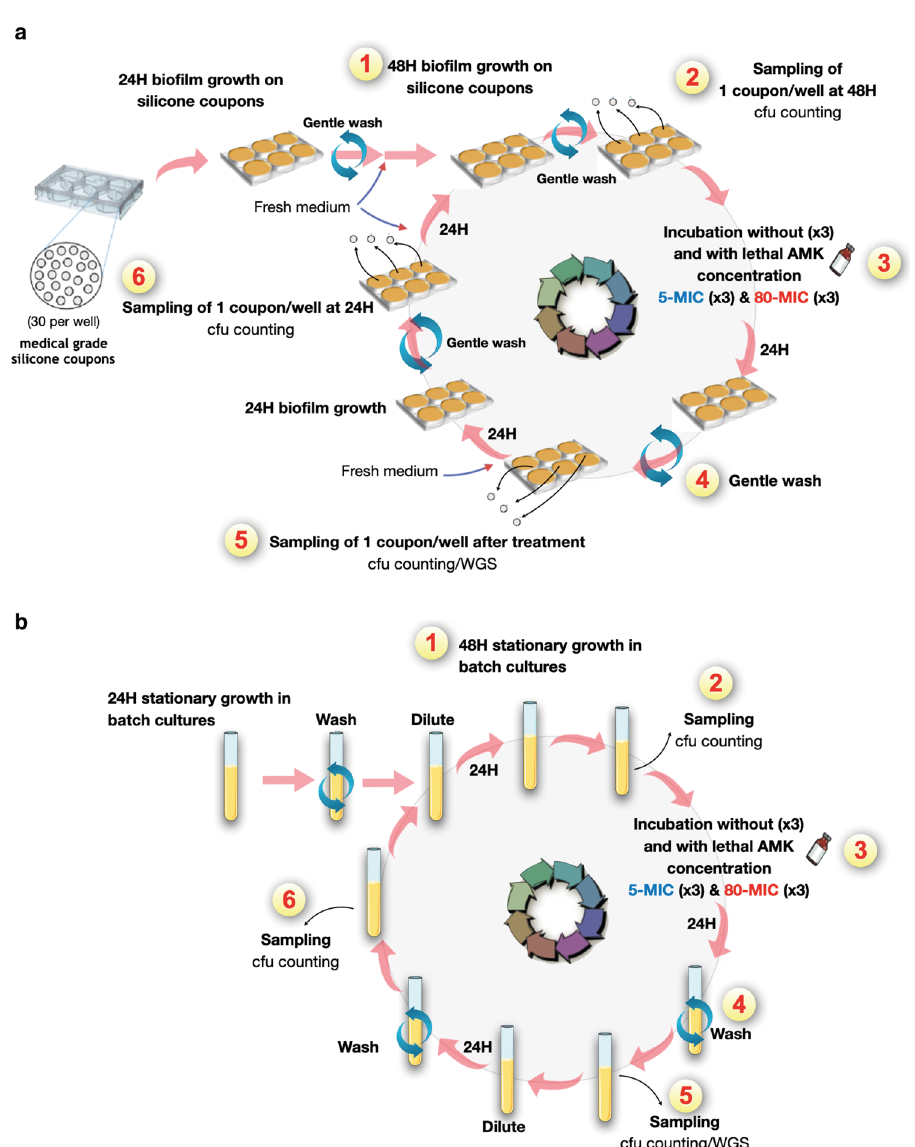
Fig. 1 Schematics of experimental evolution in bio fi lm and planktonic populations under intermittent amikacin exposure with lethal concentrations. a In vitro bio fi lm-model on silicone coupons. (1) Bio fi lms formed by E. coli LF82 strain are grown for a total of 48 h at 37 °C on silicone coupons in a 6-well plate under static conditions ( = cycle 0). (2) One coupon is sampled from each well after removing the exhausted medium and gentle wash of the wells twice with fresh LB medium. (3) Bio fi lms on silicone coupons are treated with or without amikacin (AMK) at 5- or 80-fold MICs for 24 h at 37 °C. (4) Each well is gently washed twice with fresh LB medium after removing the supernatant containing AMK. (5) One coupon is sampled from each well. Next, the survived bio fi lm cells are incubated in fresh LB medium for 24 h at 37 °C. (6) One coupon is collected after washing the wells. Then, bio fi lms are grown for another 24 h at 37 °C ( = step 1). Steps 2 – 6 are de fi ned as a series of cycles, and the experiment is performed for 10 cycles. The last cycle was stopped at step 5. Each coupon is collected in a microtube containing LB medium, and the microtubes are vortexed and sonicated to detach bio fi lm cells from silicone coupons. The bacterial number of collected sample was con fi rmed by performing CFU counts. Each collected sample is stored at − 80 °C and characterized later. b In vitro planktonic growth. (1) After washing and diluting aliquots of the 24-h pre-incubated culture of LF82 strain, the aliquots are incubated in fresh LB medium into a test tube for another 24 h at 37 °C under shaking condition ( = cycle 0). (2) Aliquots of the incubated culture are collected for further analyses. (3) The planktonic culture is treated with or without AMK at 5- or 80-fold MICs for 24 h at 37 °C under shaking condition. (4) Aliquots of treated planktonic cells are washed twice with fresh LB medium. (5) Some aliquots of the washed samples are collected. The bacterial number of collected sample was con fi rmed by performing CFU counts. Next, the remaining aliquots are diluted 100-fold in fresh LB medium and incubated for 24 h at 37 °C under shaking condition. Then, the 24 h incubated culture is washed twice with fresh LB medium. (6) Aliquots of washed samples are collected. Next, the remaining aliquots are diluted in fresh LB medium and incubated for another 24 h at 37 °C under shaking condition ( = step 1). Similar to the bio fi lm experiment, steps 2 – 6 are de fi ned as a series of cycles, and the planktonic evolution experiment is performed for 10 cycles. The last cycle was stopped at step 5. Each planktonic sample is stored at − 80 °C and characterized later, as well as bio fi lm samples. See also the corresponding Methods section. Some icons of this fi gure were extracted from